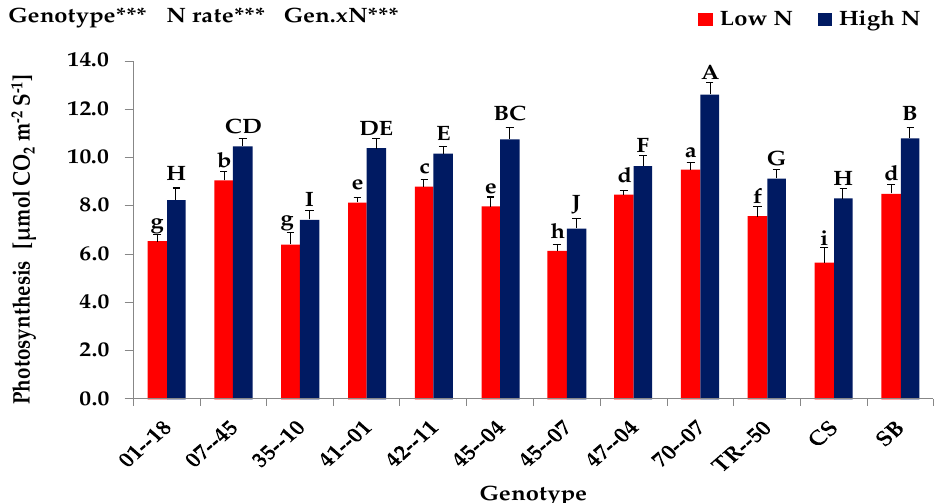
Figure 1. Photosynthesis of the ten bottle gourd genotypes and two watermelon cultivars grown under low (0.3 mM) and high (3.0 mM) N supply in Expt. 1 . Values denoted by different letters (lower- and upper-case letters for low and high N supply, respectively) are significantly different between genotypes within columns at p < 0.05. ns, non-significant. * p < 0.05, ** p < 0.01 and *** p < 0.001.